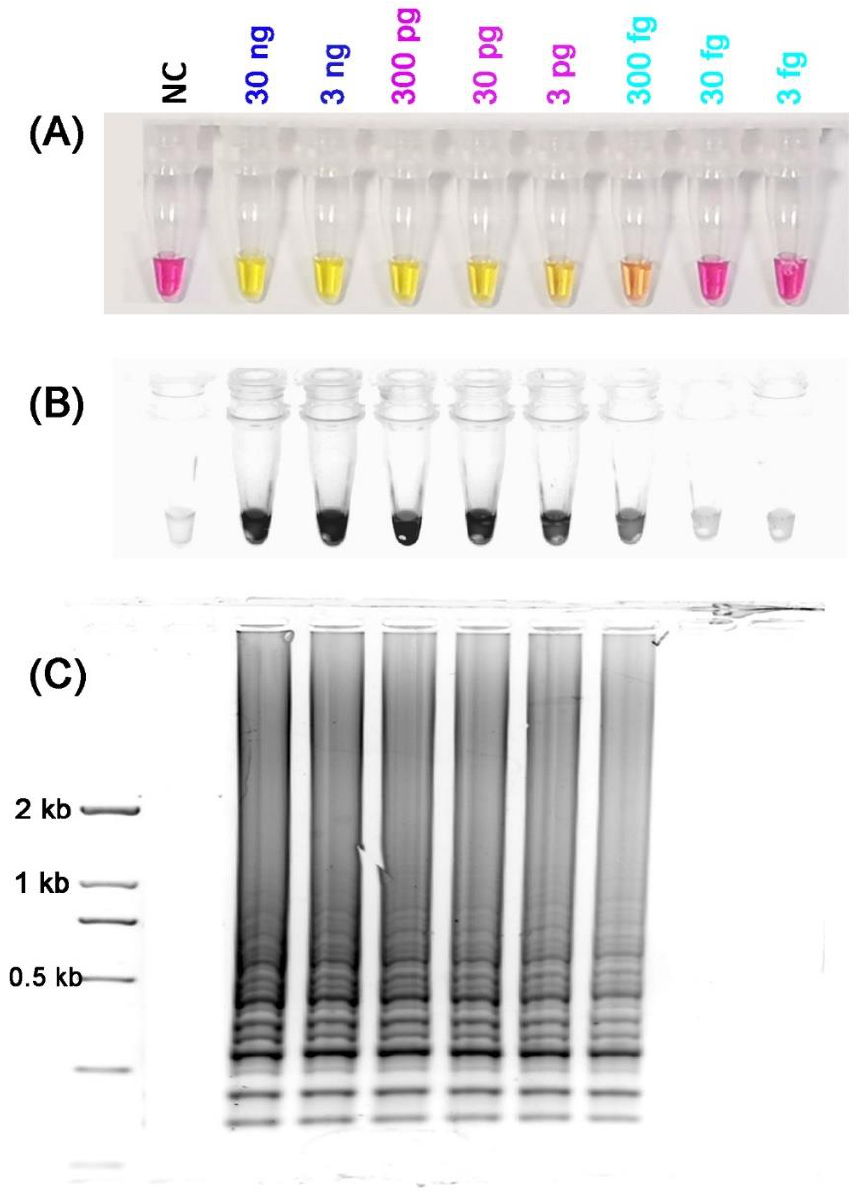
Figure 5. Identification of the detection limit of gDNA in the LAMP assay from 30 ng to 3 fg. ( A ) Checking results under visible light, ( B ) checking results under ultraviolet light with GelRed and ( C ) checking results by gel electrophoresis. NC, non-template control. The non-destructive DNA extraction method from whole specimens was applied to obtain T. japonensis gDNA from single adult and larva, suitable for the LAMP assay. A colorimetric LAMP assay was conducted to test this “crude” gDNA extraction method in a heating block. The result was also checked by gel electrophoresis. Both adult and larval samples of T. japonensis generated positive results within 60 min (Figure 6), with 100% suc- cess rates when 10 samples per adult and larva were tested. This allows the preservation of complete morphological voucher specimens for further species identification by molecular or morphological identification